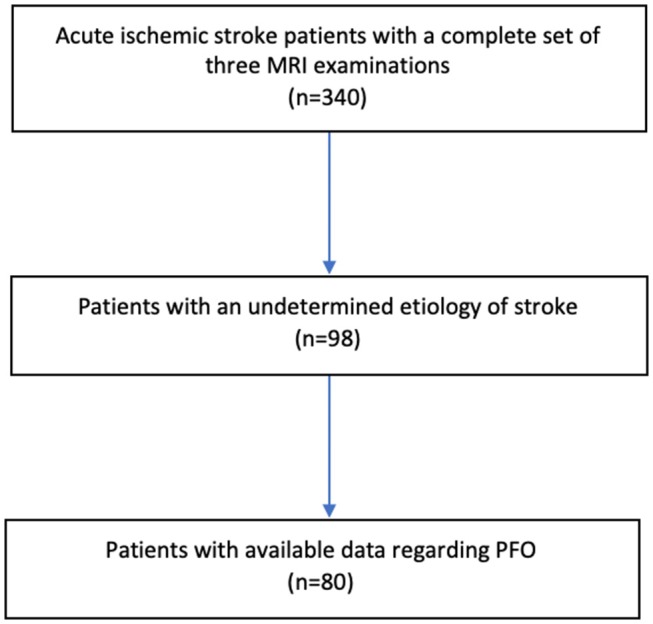
Data flow diagram.